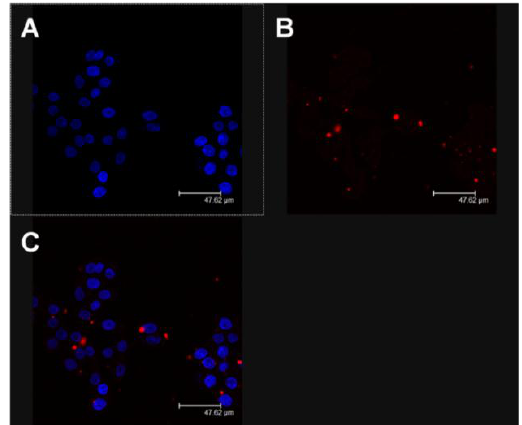
Figure 5. Confocal laser scanning microscopy (CLSM) micrographs of TPC-1 cells treated with rhodamine-labelled nanoliposomes after 3 h incubation: panel A , Hoechst filter; panel B , TRITC filter; and panel C , overlay. A representative example of three independent experiments.